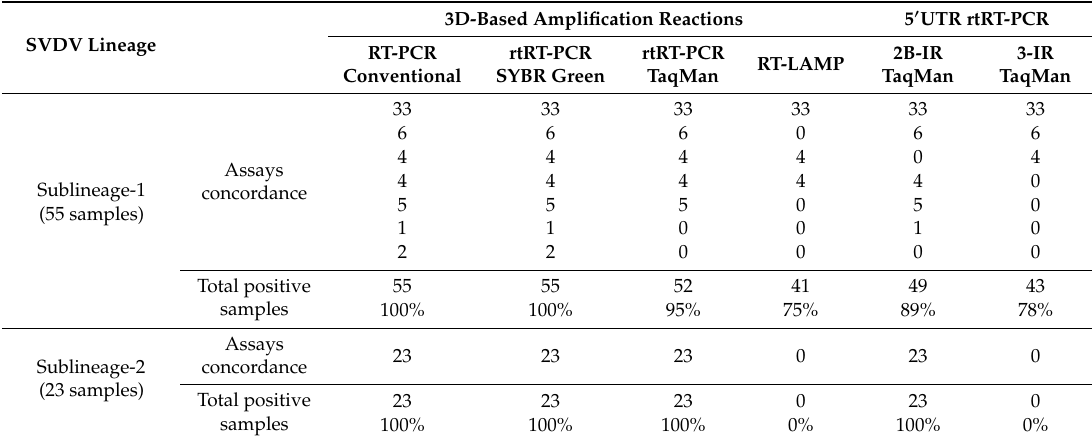
Table 3. Comparative diagnostic sensitivity of the six molecular assays tested on 78 fecal samples, each collected from di ff erent SVDV outbreaks that occurred in Italy from 1997–2014. SVDV